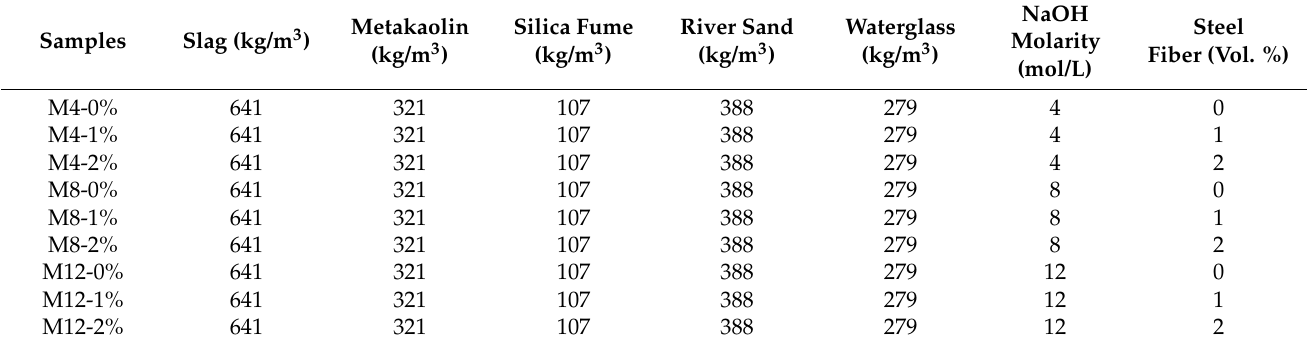
Table 2. Mixture